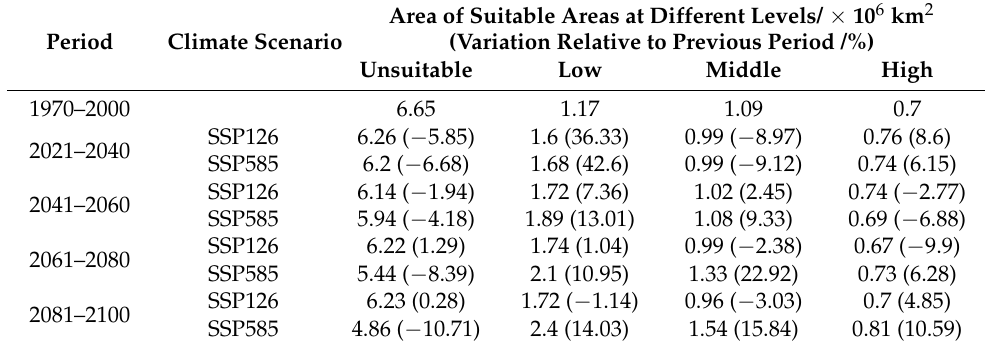
Table 5. The variation of the suitable area of C. bungei under future climate. Area of Suitable Areas at Different Levels/ × 10 6 km 2 Period Climate Scenario (Variation Relative to Previous Period /%)